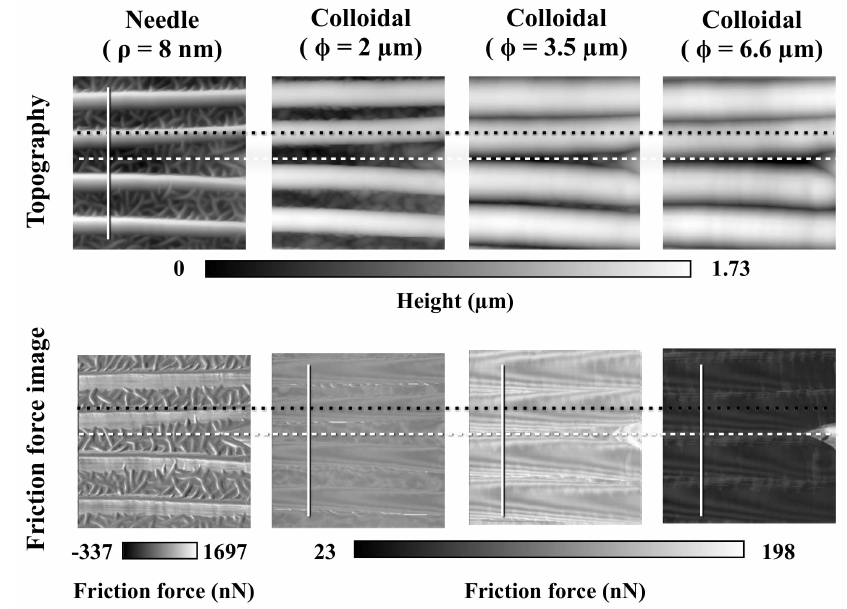
Figure 6. Friction force images obtained by AFM. Black dotted lines indicate the top of the grooves and white broken lines indicate the bottom of grooves. White lines are sampling points of the height profile and the friction force as shown in Figure 7. The scanning direction was the same (left to right), and the scanning area was 15 µ m square. Within this figure, same scale spot was measured by four different